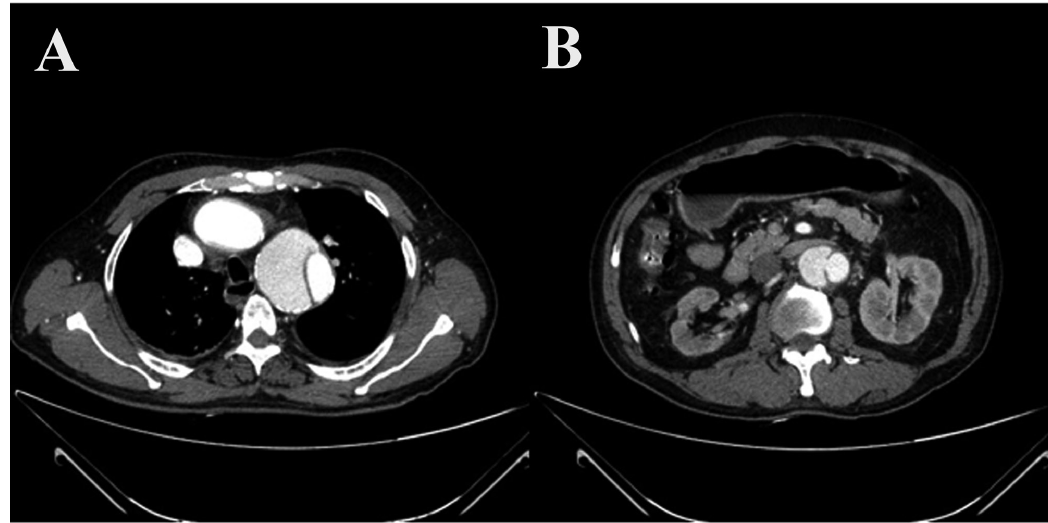
Fig. 1 - Computed tomography revealed an aortic dissection with entry and re-entry